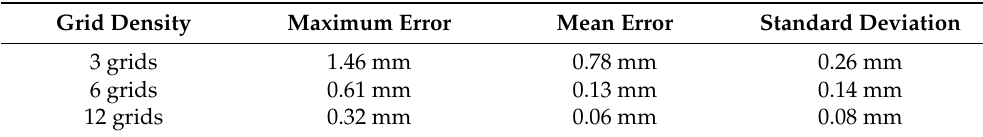
Figure 14. Lifting left outboard ( a ) and inboard ( b ) BB variable grid density results analysis. Table 3. Estimate error of the HKM. Grid Density